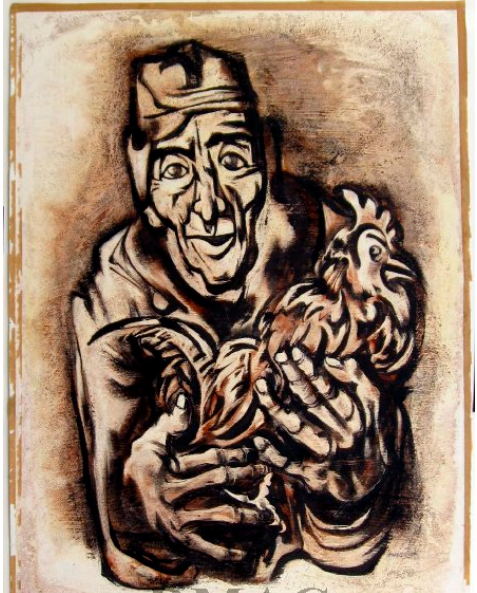
Figure 12. An example of Cook’s later work. Howard Cook, Vicente with Fighting Cock , 1952, pastel and mixed media on paper. Permanent Collection of the Roswell Museum and Art Center, Gift of the Artist, 1973.031.0006. Used with permission.